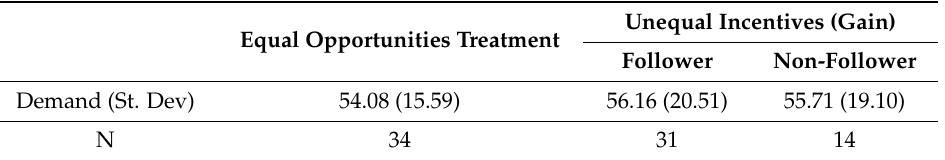
Table 6. Minimum demands of low contributors in the Gain Treatment in case of unequal contributions , differentiated for followers and non-followers.